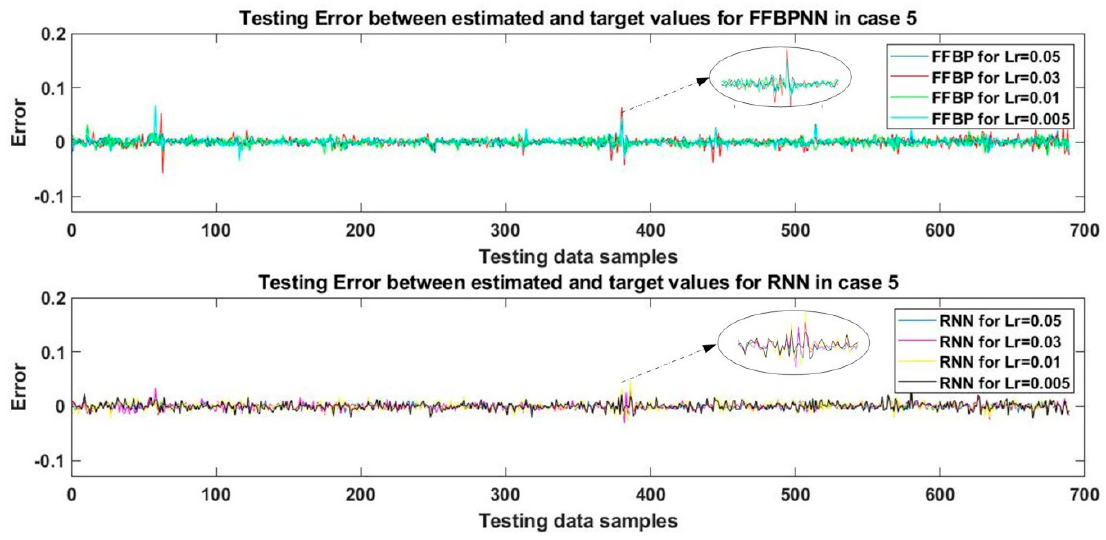
Figure 8. Testing error between estimated and target values for case 5. Table 8. Training and testing results of FFBPNN and RNN for case